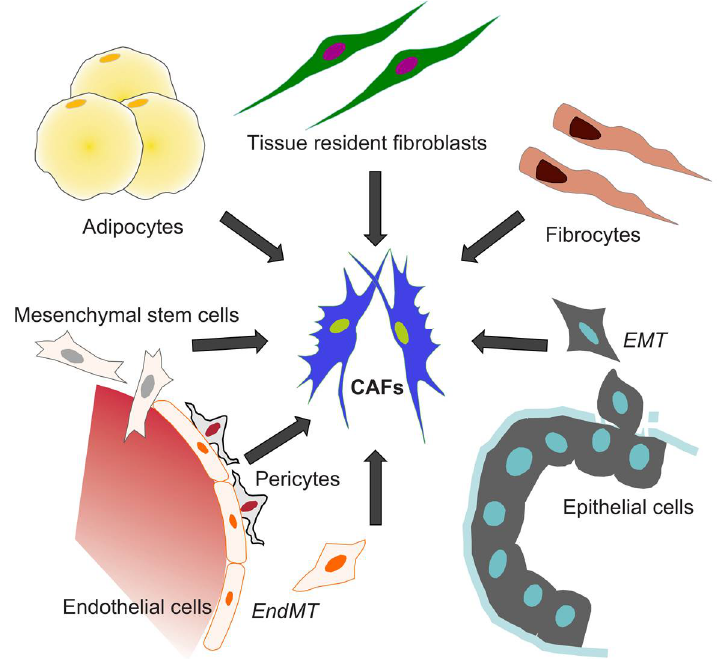
Figure 3. The origin of CAFs. Different cell types can transdifferentiate and represent the source of CAFs, including: tissue resident fibroblasts, fibrocytes, epithelial cells (through EMT), adipocytes, mesenchymal stem cells, pericytes, and endothelial progenitor cells (through EndMT).